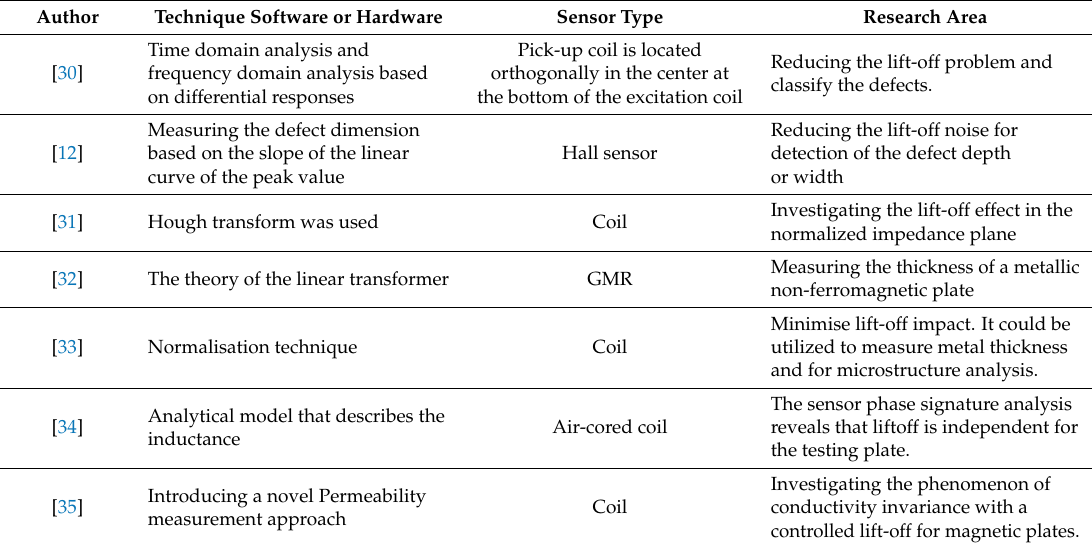
Table 1. Review of Lift-off Compensation Techniques.